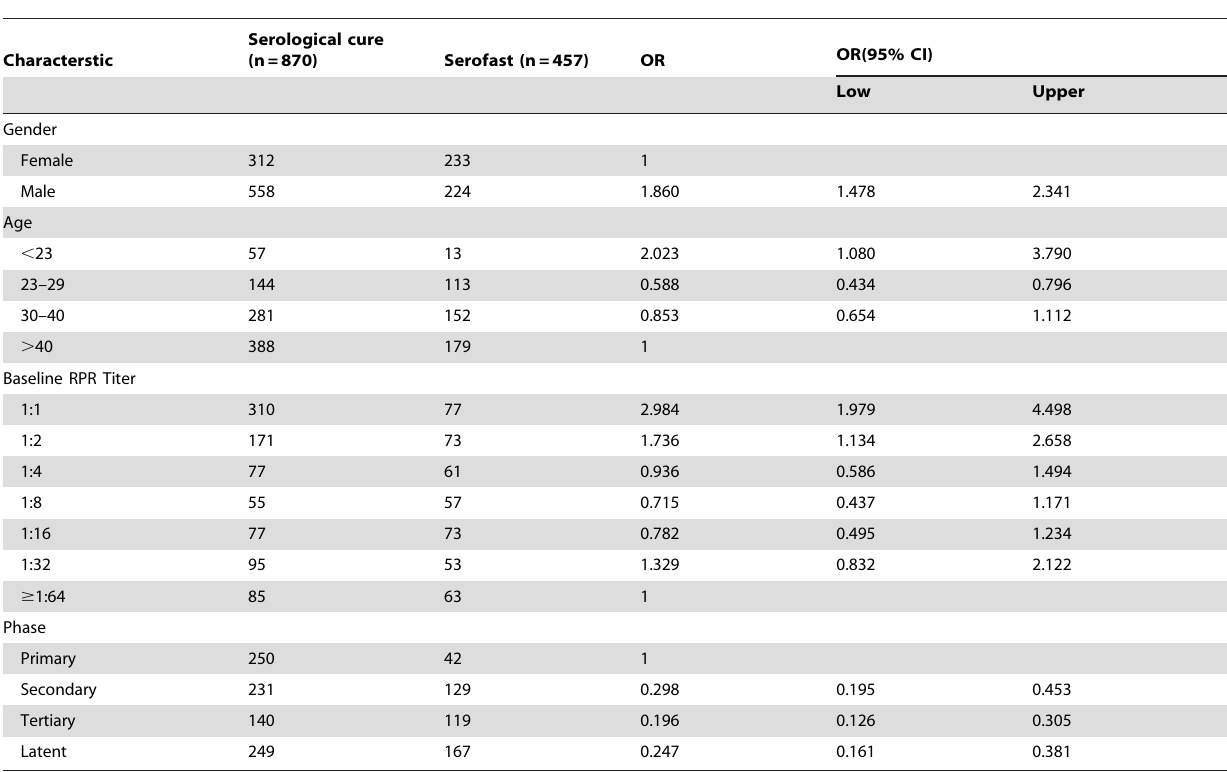
Table 1. Bivariate analysis of the characteristics of the patients who achieved serological cure.